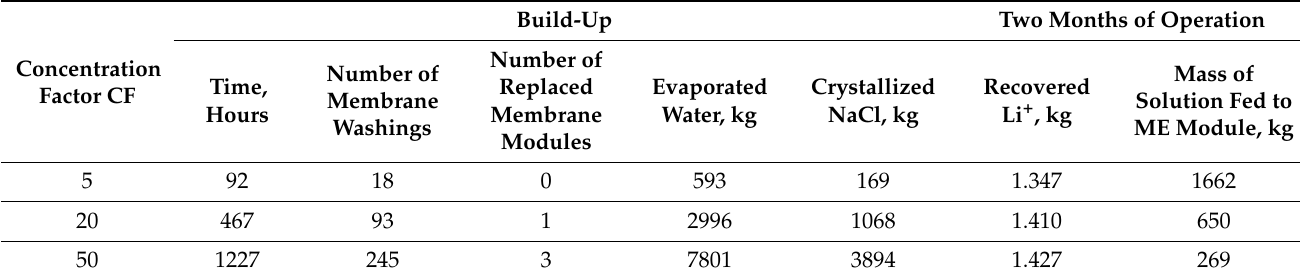
Table 8. Effect of concentration factor CF on processes operation. Simulation conditions: T f = 60 ◦ C, Rt = 4.5 h, RR = 99%, S = 2.5 m 2 , CF = 20, MPT = 50%, ER(Li + ) = 90%.